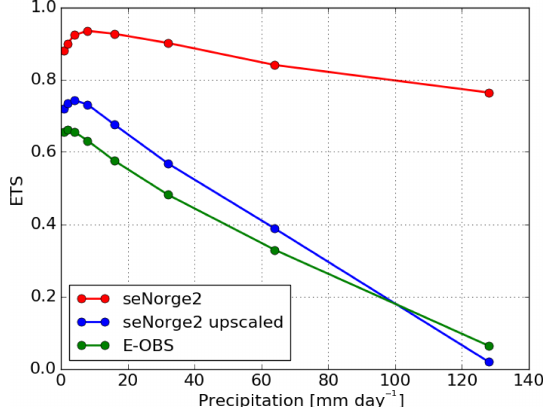
Figure 3. Equitable threat score (ETS) for daily precipitation over all the available Norwegian stations. Datasets are seNorge2 (red); seNorge2 upscaled to the E-OBS grid (blue, 0 . 25 ◦ × 0 . 25 ◦ geo- graphical latitude–longitude coordinate reference system); and E- OBS (green). Several precipitation thresholds have been consid- ered: 1, 2, 4, 8, 16, 32, 64 and 128mmday − 1 . Time interval: 30 years, from 1981 to 2010.